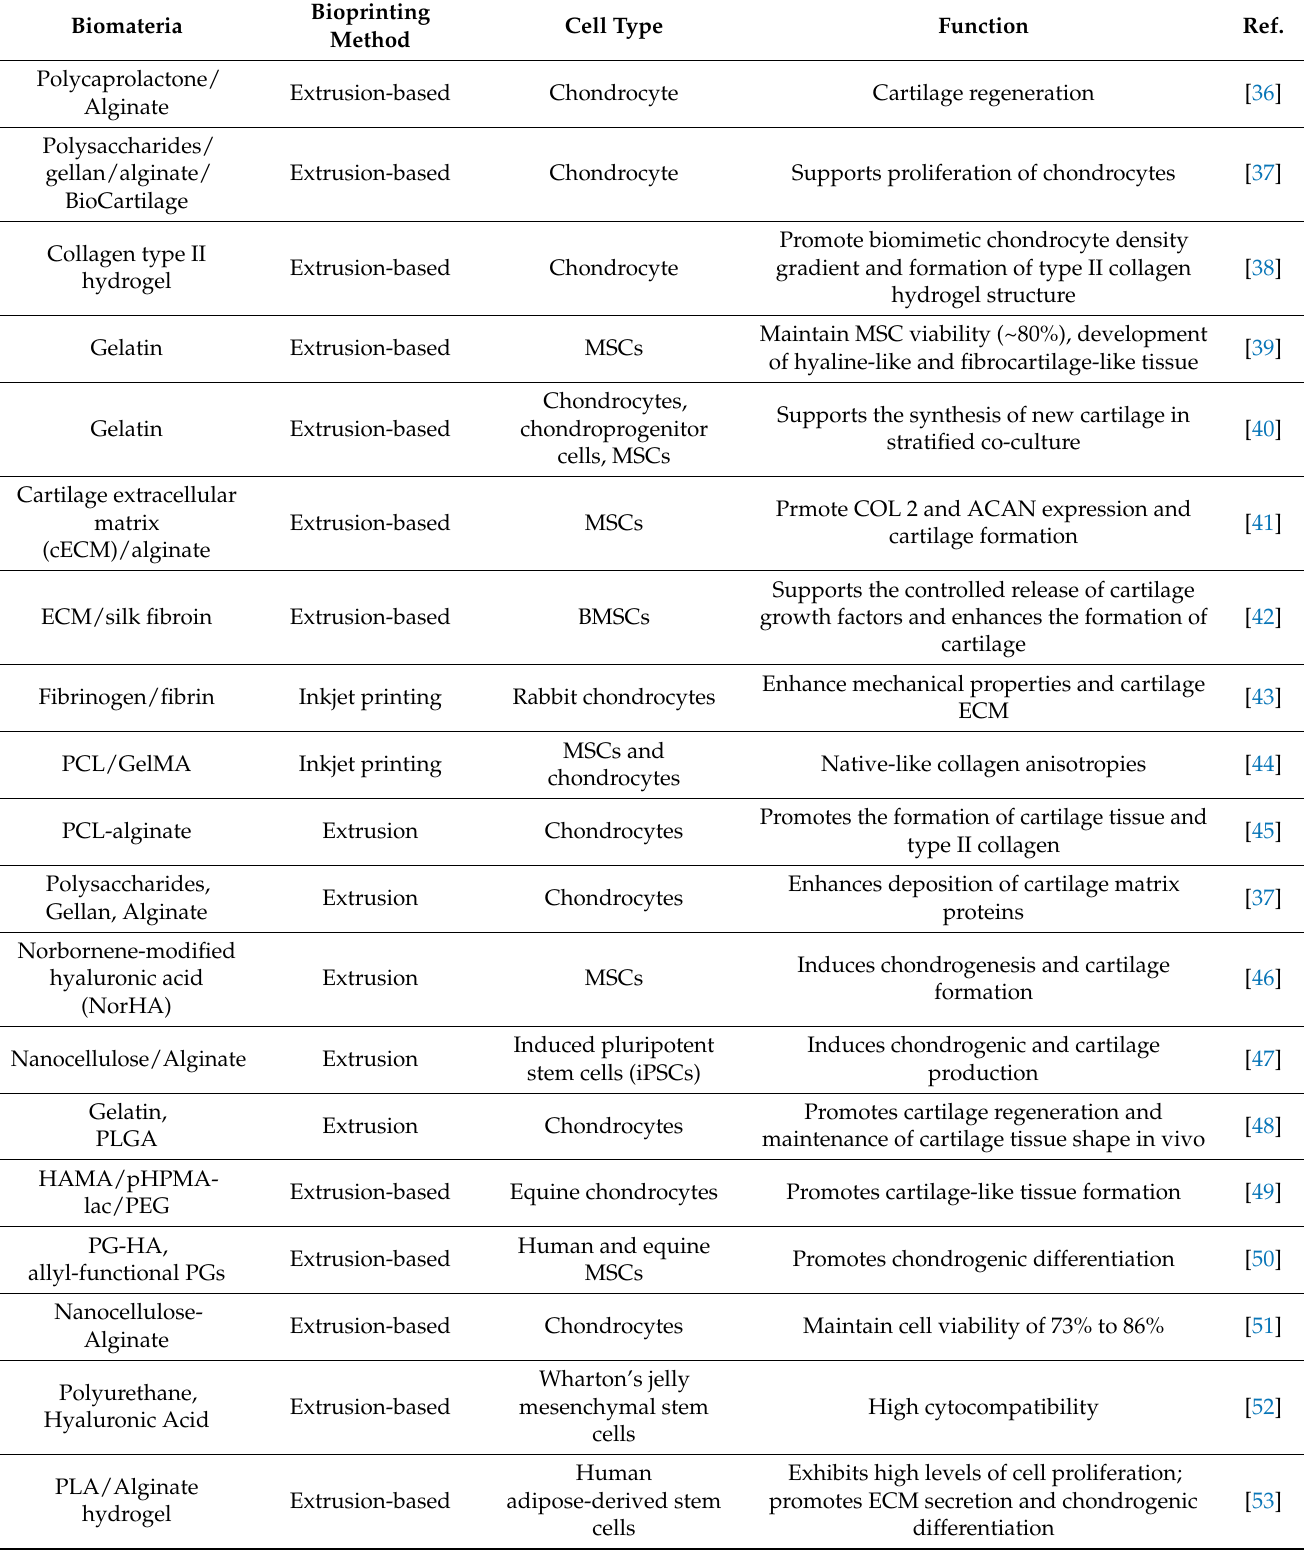
Table 1. Summary of various methods and materials for 3D printing for cartilage tissue